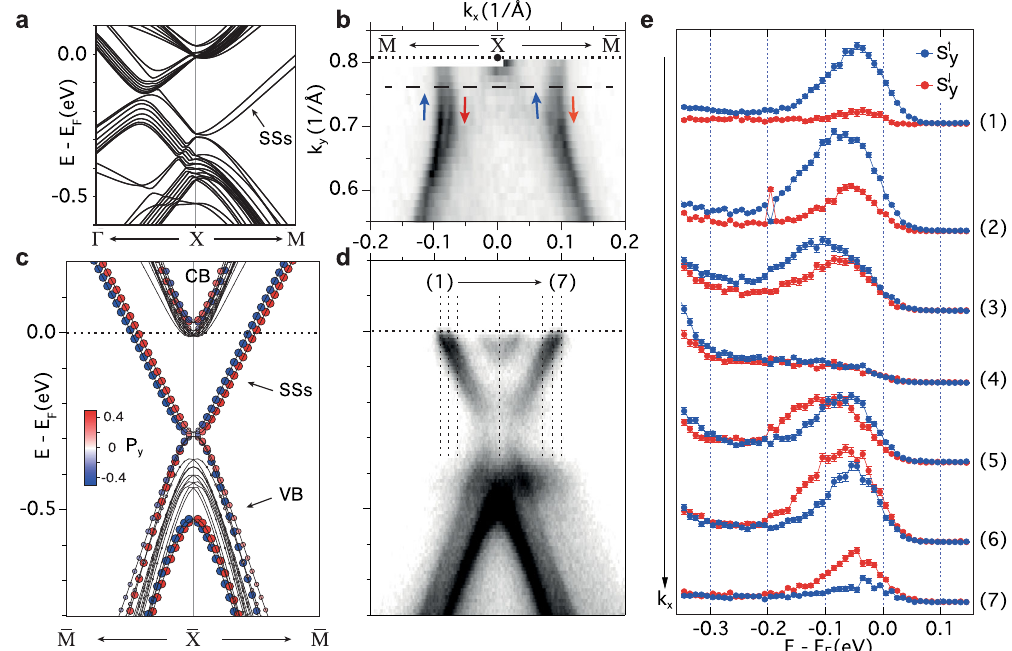
Fig. 6 Spin polarization of the surface states. a Calculated band structure with spin – orbit coupling along high-symmetry directions near the X point. b Portion of the Fermi surface measured by angle-resolved photoemission spectroscopy (ARPES) near the X point. c Calculated dispersion along (cid:1) M (cid:1) X (cid:1) M, showing the “ fl oating ” surface states. The color of the symbols encodes the P y spin polarization, whose intensity is indicated by the blue-white-red color scale. d ARPES dispersion measured along the dashed line in panel b . e Spin-resolved ARPES spectra for the y spin component measured at positions 1 – 7 in panel d . In the experiment the photon energy corresponds to 48.5 eV. The error bars in panel e represent the statistical error as described in the “ Methods ”